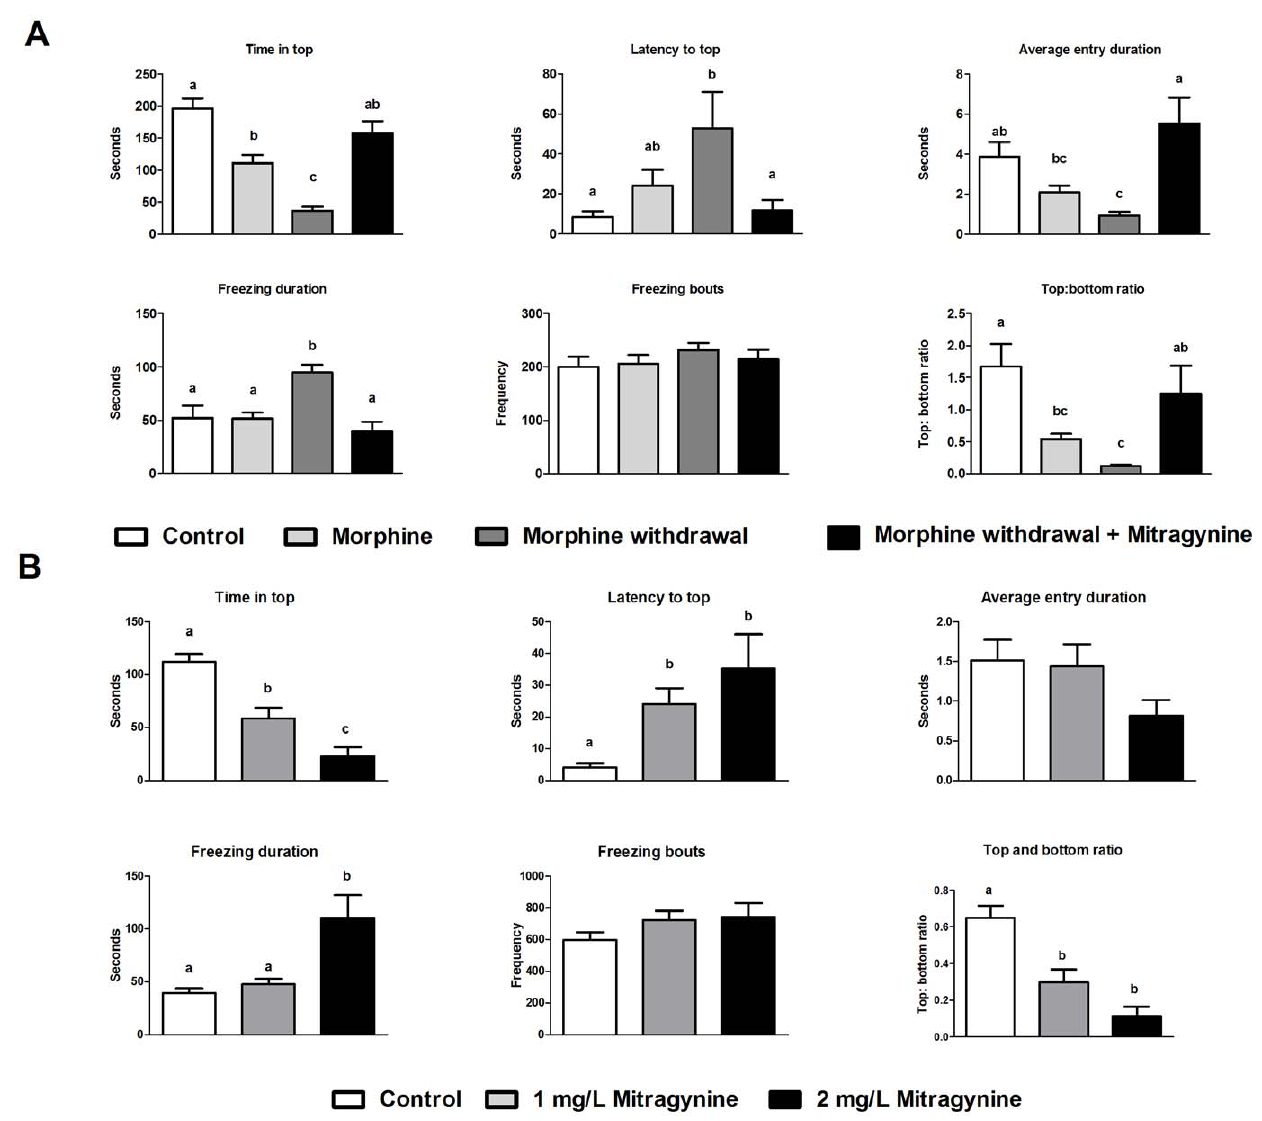
Figure 2. Effects of morphine treatment, morphine withdrawal and mitragynine on swimming behavior in adult zebrafish using the novel tank diving test. (A). Effect of two weeks chronic morphine treatment (1.5 mg/L), 24 h morphine withdrawal and morphine withdrawal in presence of 2 mg/L mitragynine on swimming behavior of zebrafish. (Control, n=17; morphine treatments, n=25; morphine withdrawal, n=22; morphine withdrawal + mitragynine, n=22). All data were presented in mean 6 SEM. Mean values were subjected to one way ANOVA and where applicable, ranked by Tukey test (P , 0.05); mean values with same letter are not significantly different. (B) Effect of 20 min acute mitragynine treatment (1 mg/L and 2 mg/L) on swimming behavior of zebrafish. (Control, n=21; 1 mg/L mitragynine, n=20; 2 mg/L mitragynine, n=21). All data were presented in mean 6 SEM. Mean values were subjected to one way ANOVA and where applicable, ranked by Tukey test (P , 0.05); mean values with same letter are not significantly